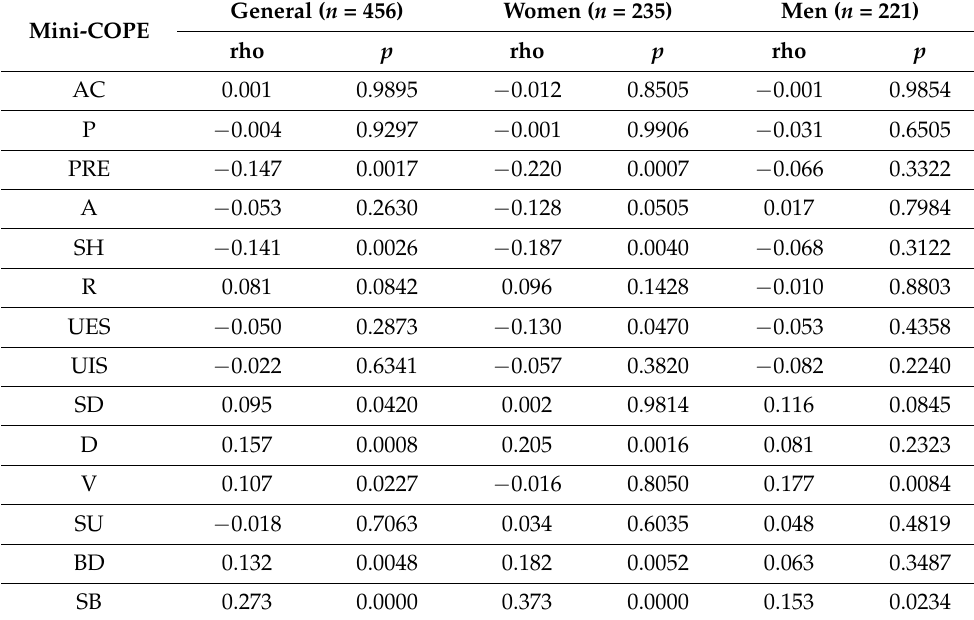
Table 4. Strategies for coping with difficult situations (14 scales) and the perceived level of stress. General ( n = 456) Women ( n = Mini-COPE